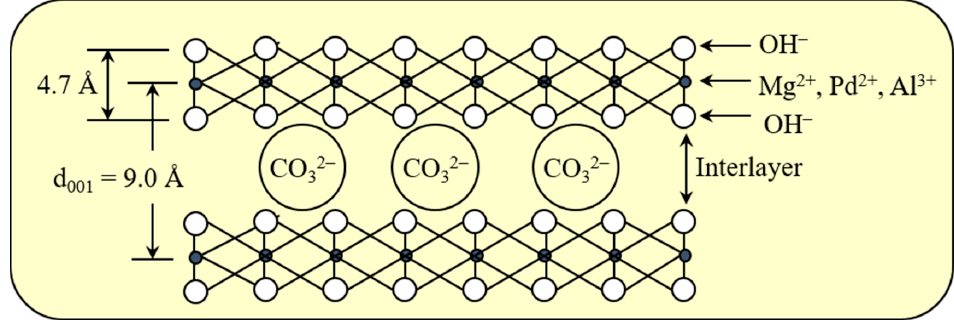
Figure 1. Structural model of the Pd 0.016 Mg 3 Al(OH) 16 CO 3 ∙ x H 2 O hydrotalcite used in this study.